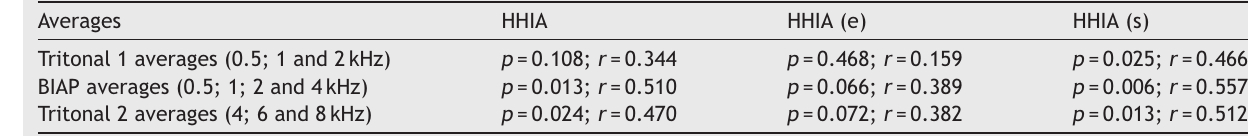
Correlations between tonal averages (dBNA) with total scores of HHIA and its domains. Averages HHIA HHIA (e) HHIA (s) Tritonal 1 averages (0.5; 1 and 2 kHz) p = 0.108; r = 0.344